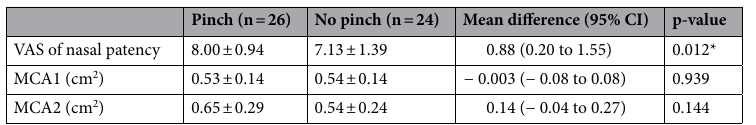
Table 2. Nasal patency after nose-blowing.